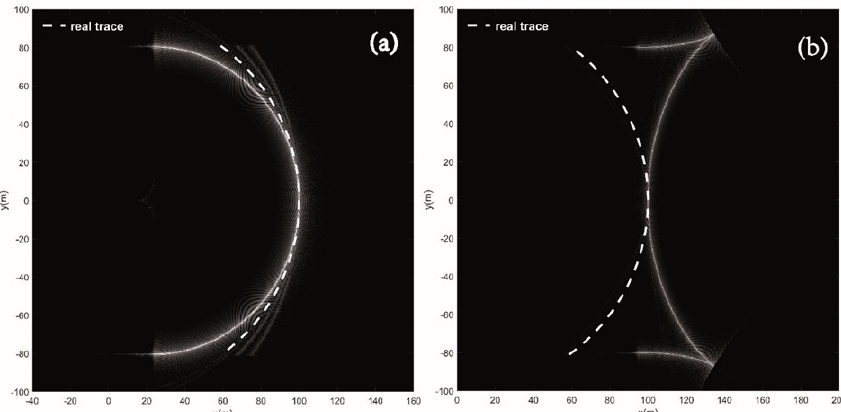
Figure 17. Target’s real trace and moving target SAR image. ( a , b ) are the SAR images of a target moving in the clockwise and counter-clockwise directions, respectively. The speed v t , rotating radius r 0 , and angle (at t = 0) ϕ were 4 m/s, 100 m, and 0 ◦ , respectively. The real trace is indicated by a dashed